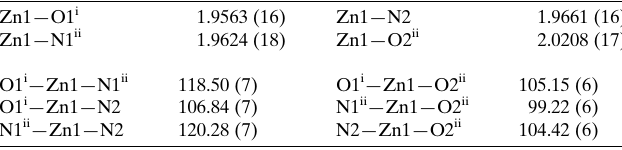
Table 1 Selected geometric parameters (A˚ , (cid:3) ) for 1 .